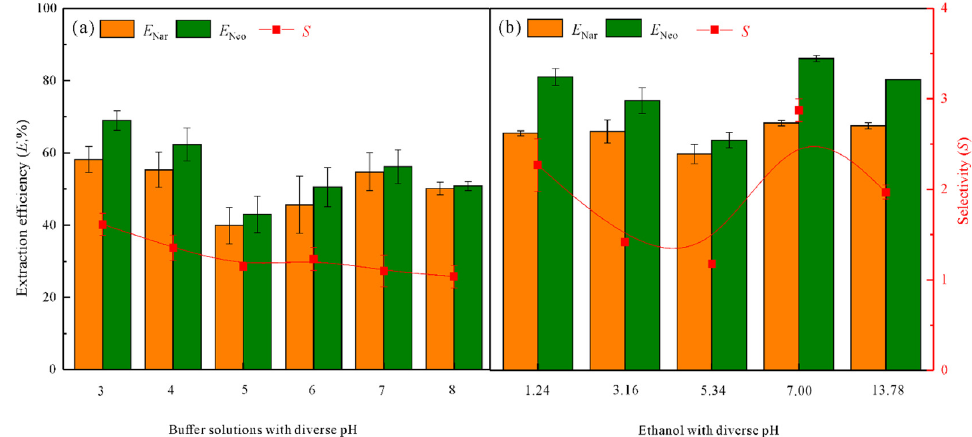
Figure 5. Effects of the ( a ) buffer solutions with diverse pH and ( b ) ethanol with diverse pH on the E and S values. The extraction conditions were as follows: DESs of 29 wt%, PL 64 of 61 wt%, temperature of 25 ◦ C.